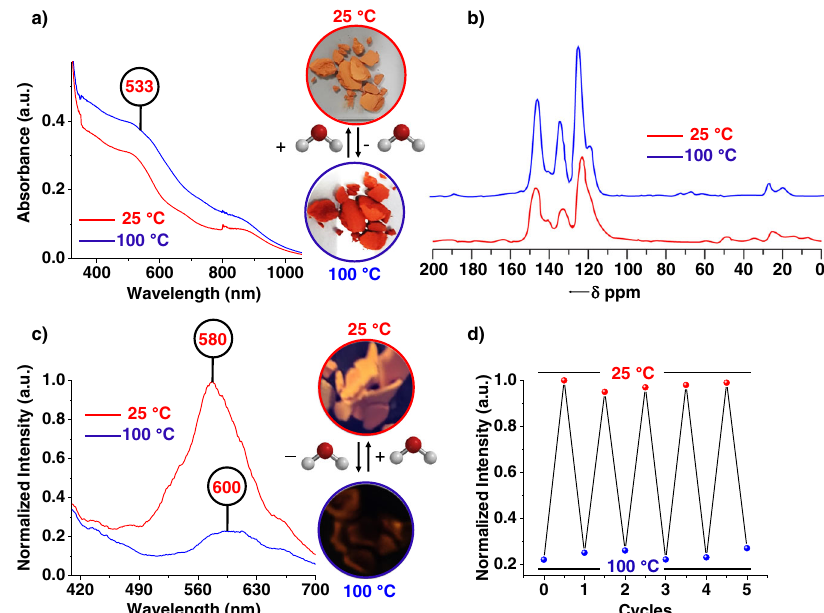
Fig. 4 Solid-state thermochromic properties of TGH + (cid:129) PD COF material. a UV – Vis – NIR spectra of unactivated TGH + (cid:129) PD and its change after heating to 100 °C, inset showing thermochromic behavior of TGH + (cid:129) PD with reversible color change. b 13 C-CP/MAS NMR spectra of unactivated TGH + (cid:129) PD and after heating to 100 °C [ δ = chemical Shift]. c Emission spectra ( λ ex = 375 nm) of unactivated TGH + (cid:129) PD (red line) and after heating to 100 °C (blue line). d Reversible change in fl uorescence intensity of TGH + (cid:129) PD upon alternate heating and cooling cycles ( λ ex = 375